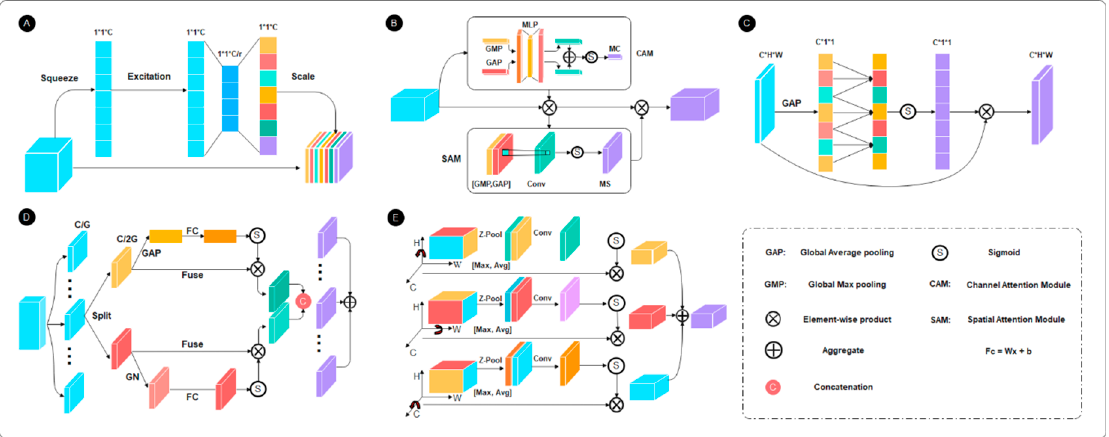
Figure 2. The architecture of utilized AMs, including ( A ) SE, ( B ) CBAM, ( C ) ECA, ( D ) Shuffle, ( E ) Triplet attention. In each training session, one of these AMs is placed into 4 attention blocks.